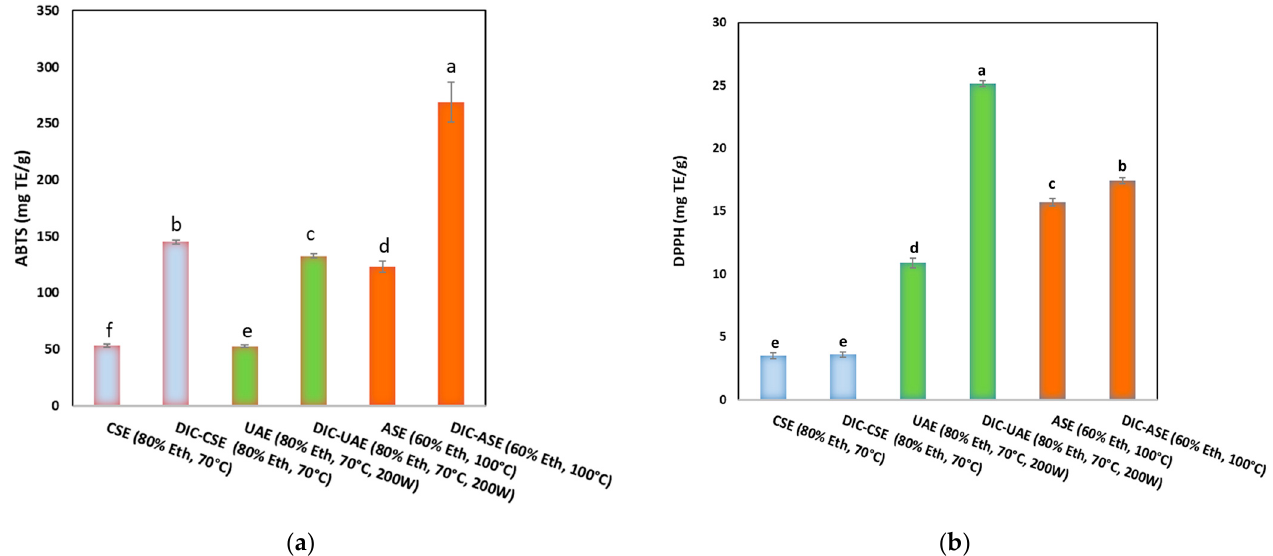
Figure 2. ABTS-RSA (mg TE/g DM) ( a ), DPPH-RSA (mg TE/g DM) ( b ) of orange byproduct extracts obtained for CSE, UAE, and ASE with or without DIC pretreatment. Values followed by the same letter are not statistically significant according to Tukey’s multiple range test at a significance level of p <